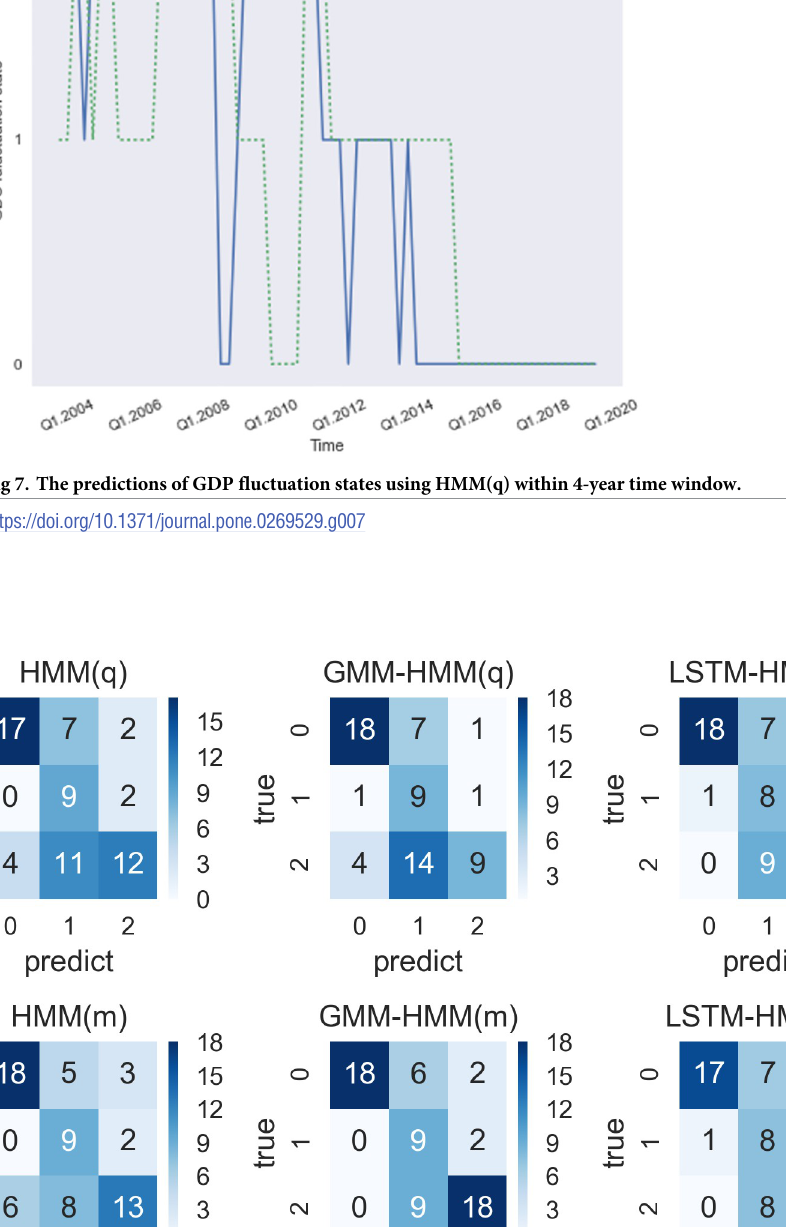
PLOS ONE | https://doi.org/10.1371/journal.pone.0269529 June 17,